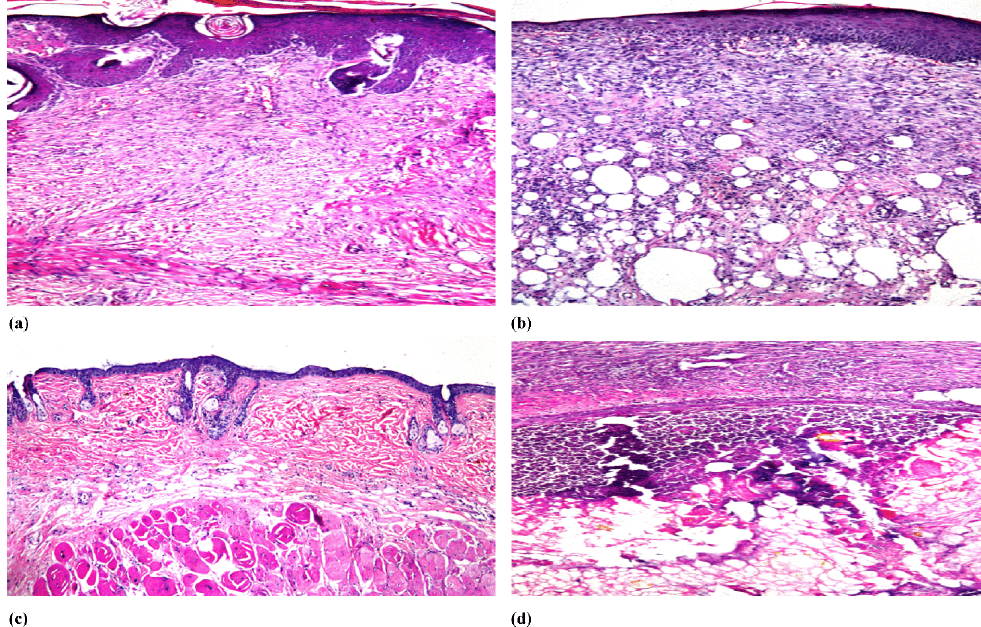
Figure 7. Photomicrographs of tissue sections stained with H and E (16x mag), represent skin of mice treated with silver sulphadiazine, showing focal hyperkeratosis and acanthosis in the epidermis as well as focal granulation tissue formation in the underlying dermis ( a ), skin of mice treated with F2(AuNPs-PF127-HPMC), showing hyperkeratosis and acanthosis in the epidermis with granulation tissue formation and inflammatory cells infiltration in the underlying dermis ( b ), skin of mice treated with F1(AuNPs-PF127), showing intact normal histopathological structure of epidermis and dermis with hyalinosis in underlying skeletal muscle and few inflammatory cells infiltration ( c ) and skin of mice treated with saline showing focal suppuration with liquefaction and pus formation in the subcutaneous tissue ( d ).